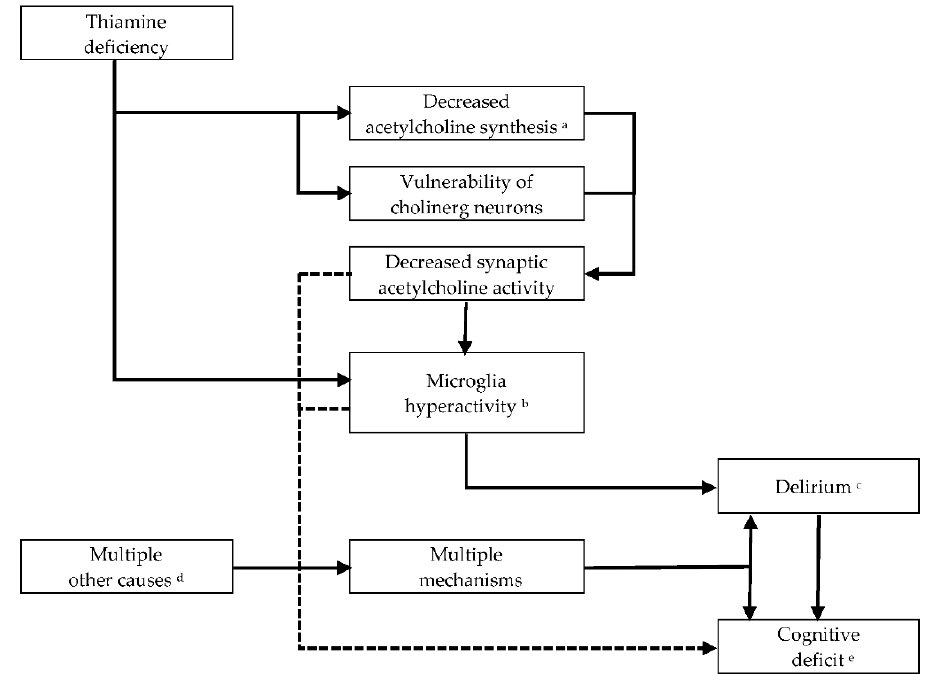
Figure 1. Acetylcholine in Wernicke-Korsakoff syndrome. a Acetylcholine synthesis: Choline is acetylated to the neurotransmitter acetylcholine by choline acetyltransferase (CAT) and by use of acetyl-CoA. In the metabolism of glucose, the enzymatic step that is catalyzed by pyruvate dehydrogenase requires thiamine pyrophosphate, the active form of thiamine. Reduced activity of pyruvate dehydrogenase may result in deficiency of acetyl-CoA and reduced synthesis of acetylcholine [45]. b Wang and Hazell (2011) observed induction of microglia activity in their thiamine deficient rodent model [39]. c Based on an hypothesis of van Gool and colleagues (2011) microglia hyperactivity may lead to a delirium [16]. Delirium due to thiamine deficiency = Wernicke encephalopathy [15]. d For instance, alcohol withdrawal, brain injury, hepatic failure, renal failure, brain injury, infections, and electrolyte disorders. e Neurocognitive disorder due to thiamine deficiency = Korsakoff syndrome.